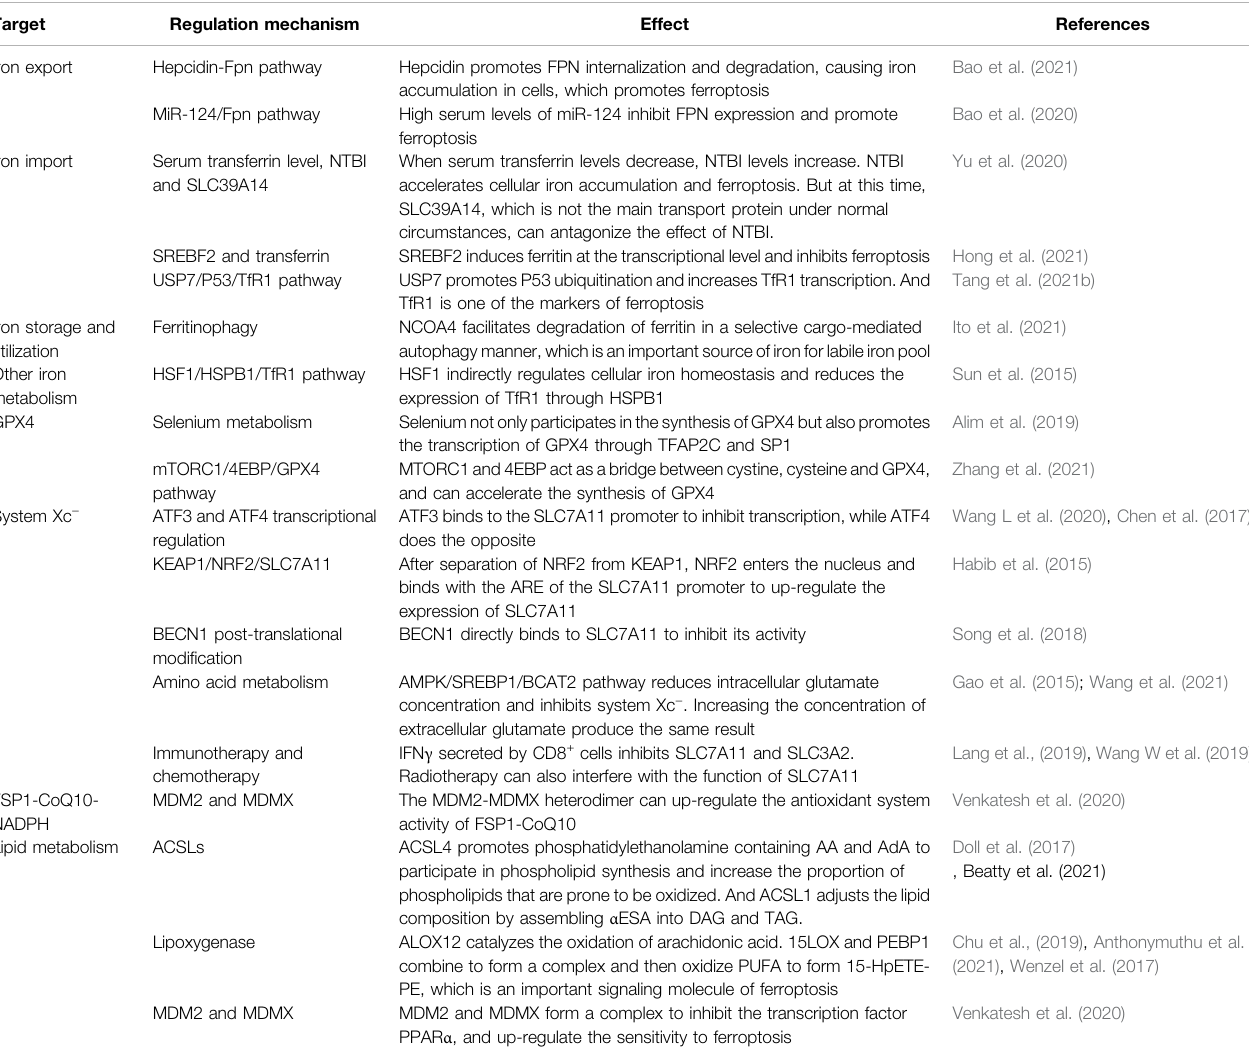
TABLE 1 | The regulatory mechanism of